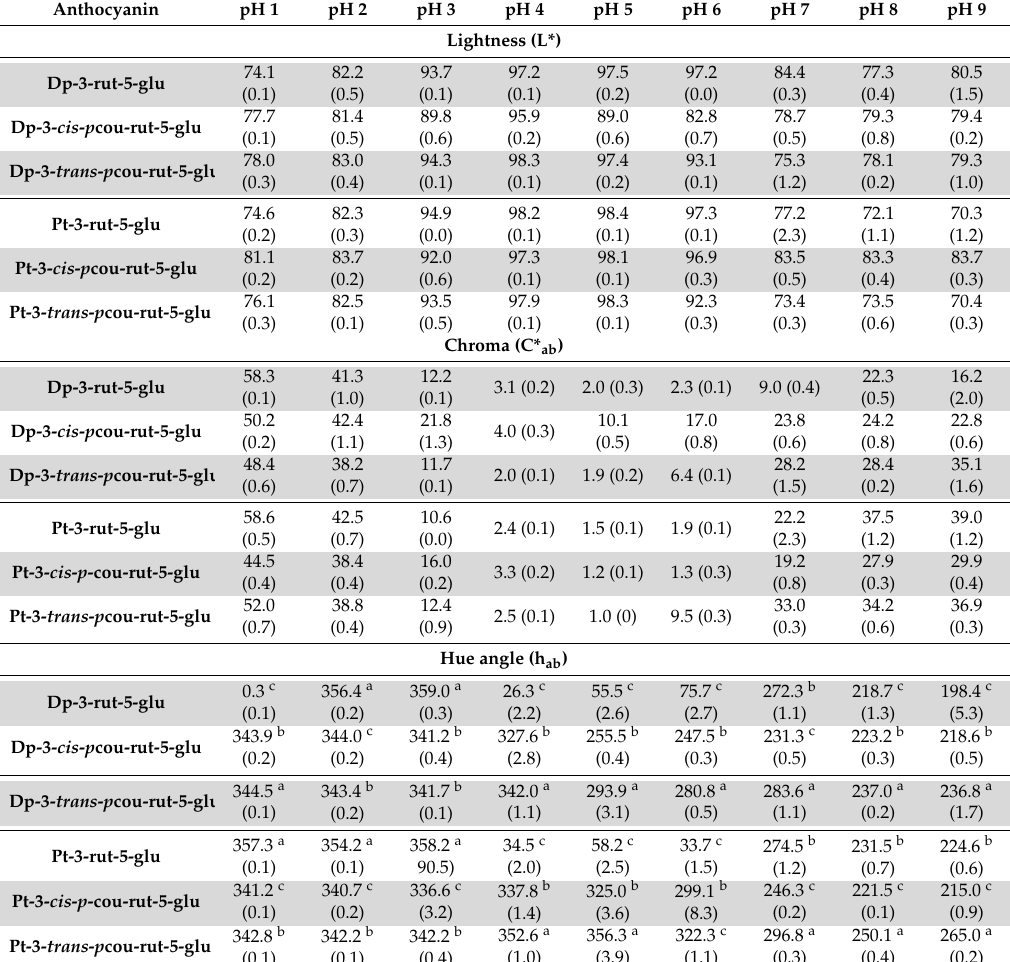
Table 2. CIE-L*C* ab h ab colorimetric values (standard deviation) of delphinidin (Dp) and petunidin (Pt) derivatives in pH 1–9, n = 3. Different superscript letters indicate significant differences ( p < 0.05) between derivatives of the same anthocyanidin in the same